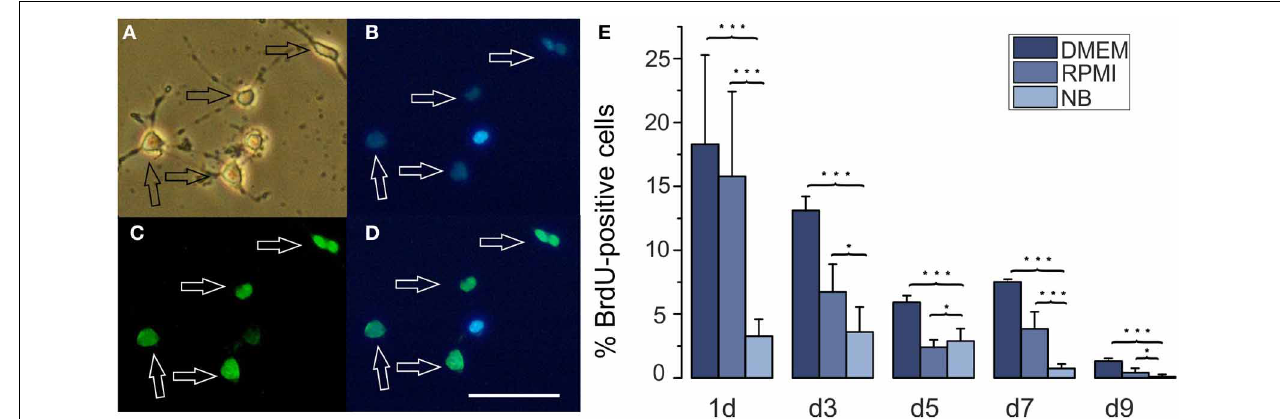
FIGURE 3 | Effects of different basal culture media on BrdU incorporation. (A–D) Examples of a BrdU stained culture (A) phase contrast picture, (B) Hoechst 33258 staining of the same image, (C) BrdU stain, (D) merged pictures (B) and (C) , calibration bar represents 50 μ m.